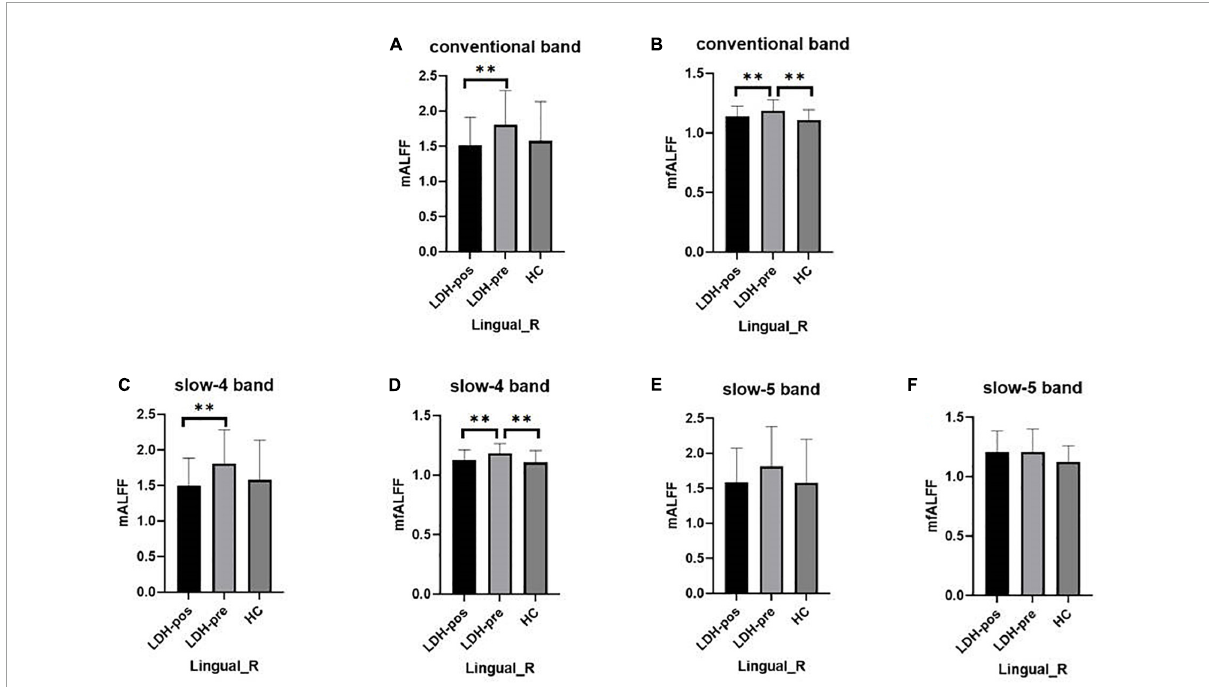
FIGURE4 The mean ALFF and fALFF values of signals extracted from right lingual gyri of each participant. The LDH patients and HCs were compared using two-sample t -tests, and LDH patients before and after SMT were compared by paired t -tests. ∗∗ Indicates significance level at p < 0.01 (two -tailed). (A,B) The mALFF value (A) and mfALFF value (B) in the conventional band from the right lingual gyri of the HC, the patients with LDH before (LDH-pre) and after the SMT treatments (LDH-pos). (C,D) The mALFF value (C) and mfALFF value (D) in the slow-4 band from the from the same brain region of the three group. (E,F) The mALFF value (E) and mfALFF value (F) in the slow-5 band.